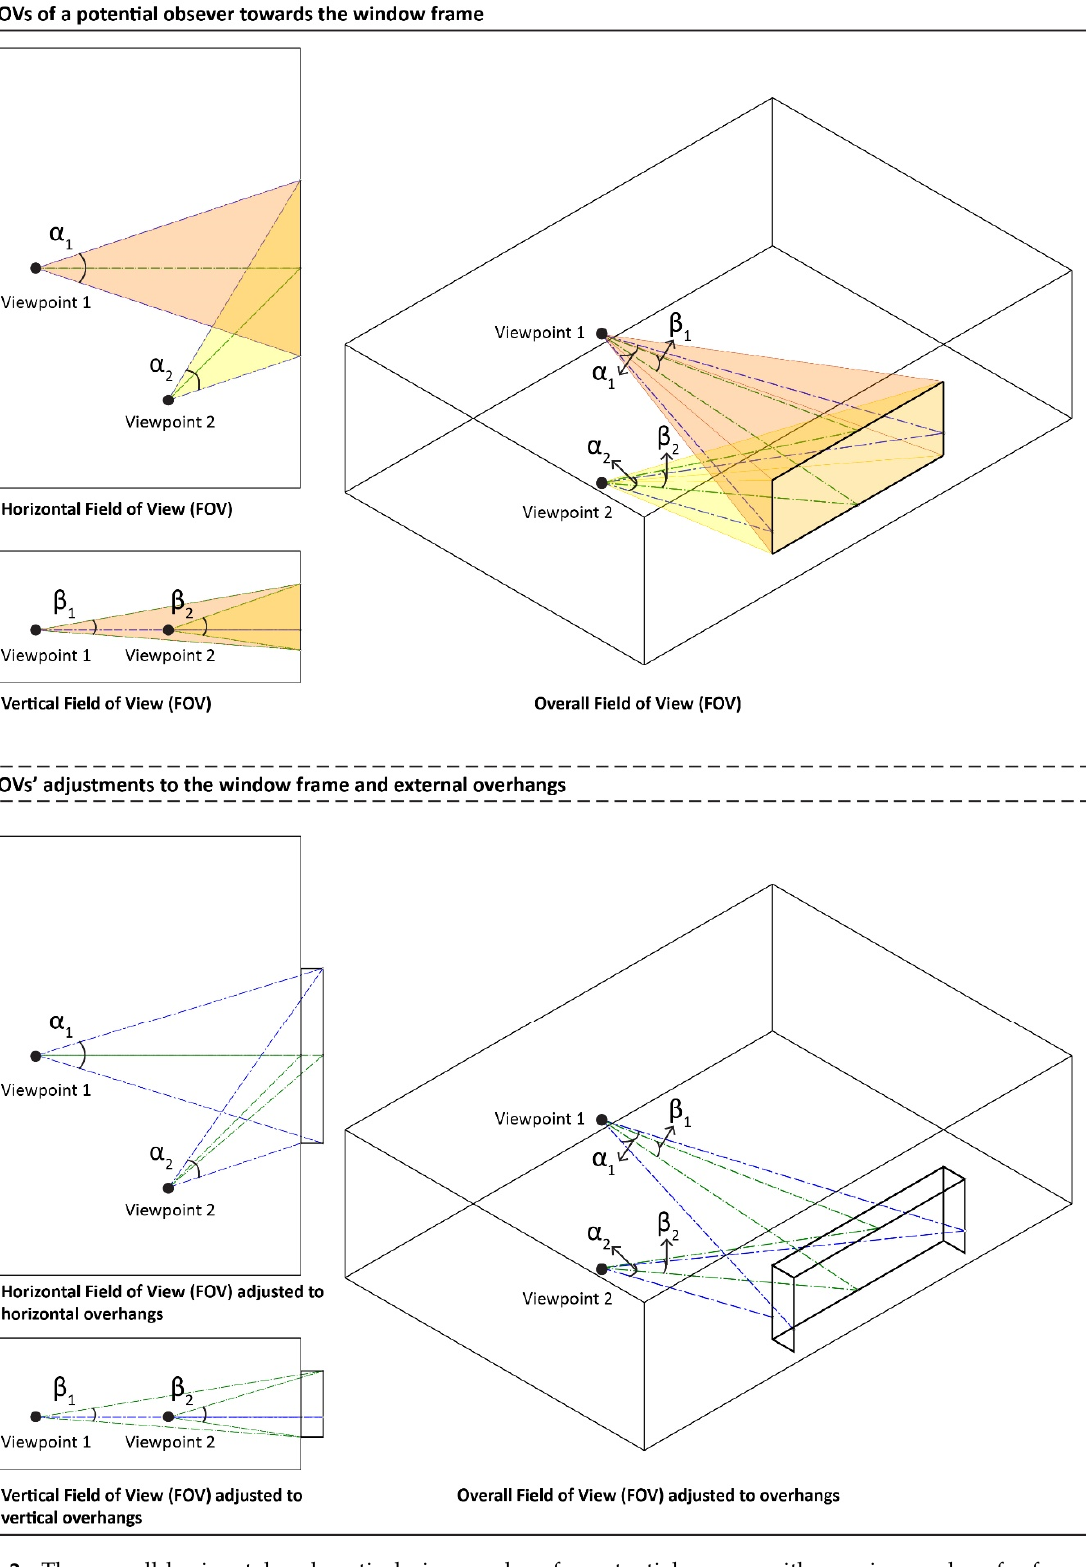
Figure 2. The overall horizontal and vertical view angles of a potential person with opening angles of a four-sided rectangular pyramid projected from different viewpoints towards the window frame and external overhangs.